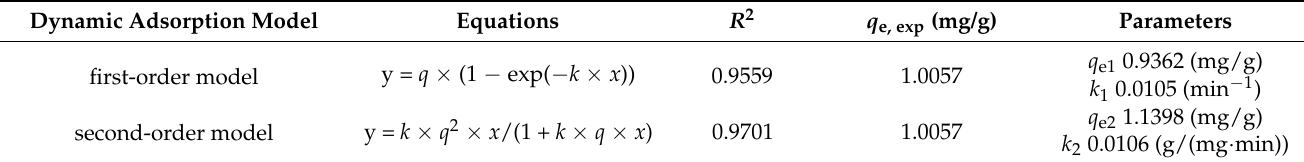
Table 6. Kinetic parameters for pseudo first-order and pseudo-second-order dynamic models for the adsorption of ammonium on bio-ceramsite.